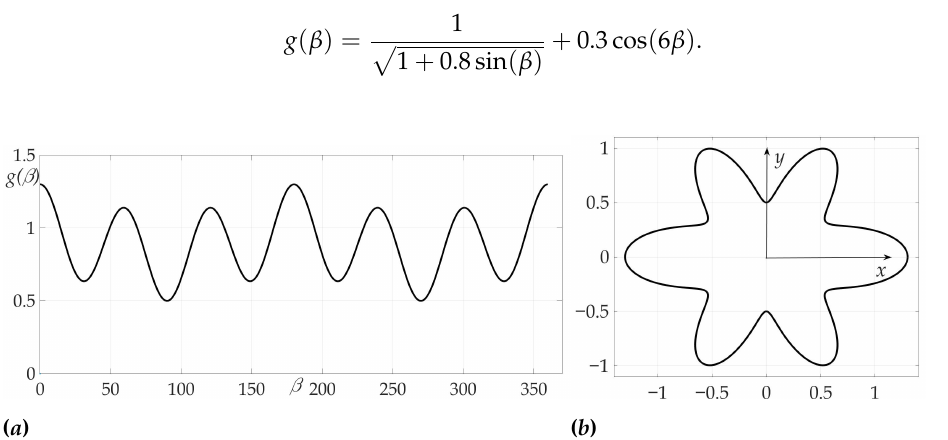
Figure 8. Radiation pattern as an dependence g ( β ) in polar coordinates ( a ) and on the Cartesian plane ( b